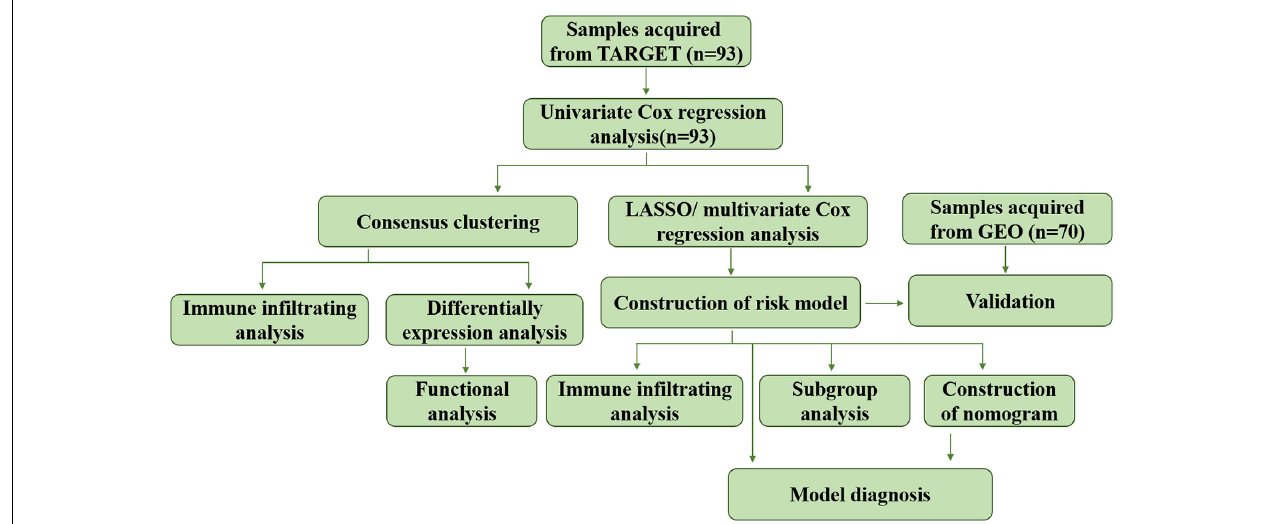
FIGURE 1 | Flow chart of the data analyzing